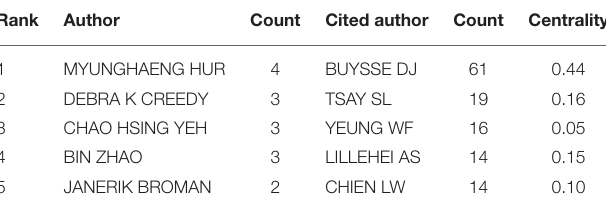
TABLE 3 | Top 5 authors and cited